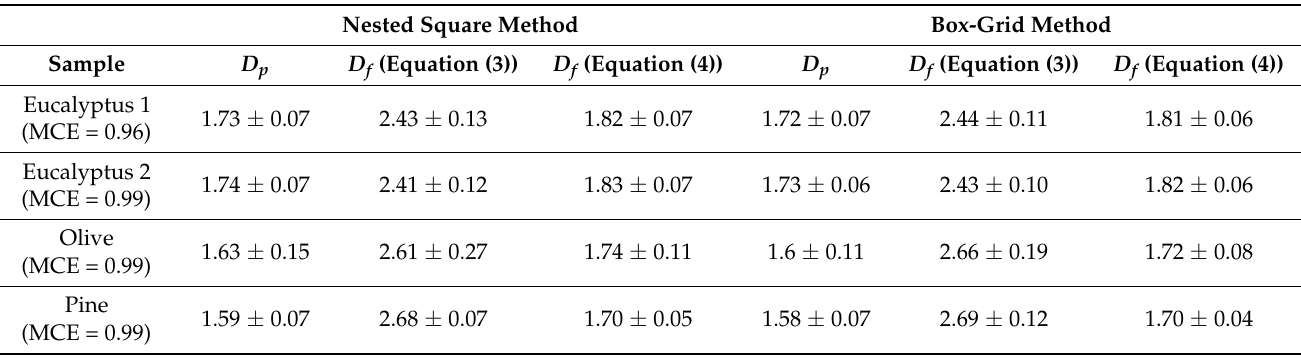
Table 1. The average 2D fractal dimensions calculated using BGM and NSM and the 3D fractal dimensions derived using Equations (3) and (4). (Errors are ± 1 σ